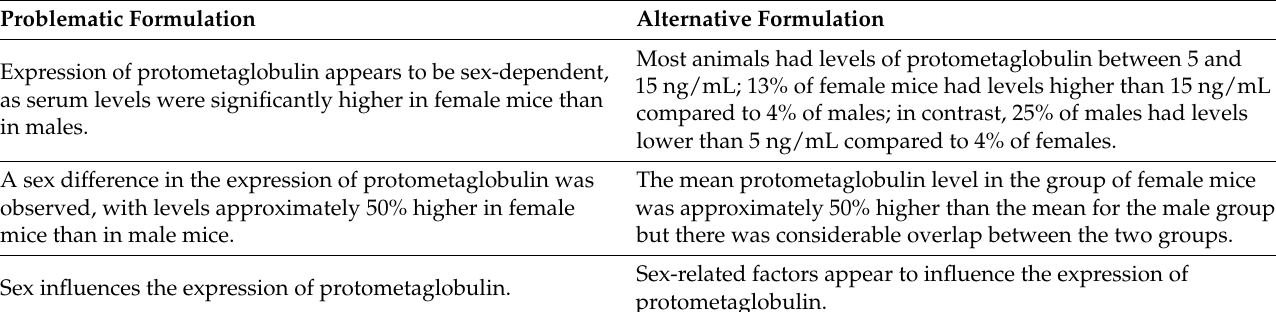
Table 3. Alternative formulations for describing male–female